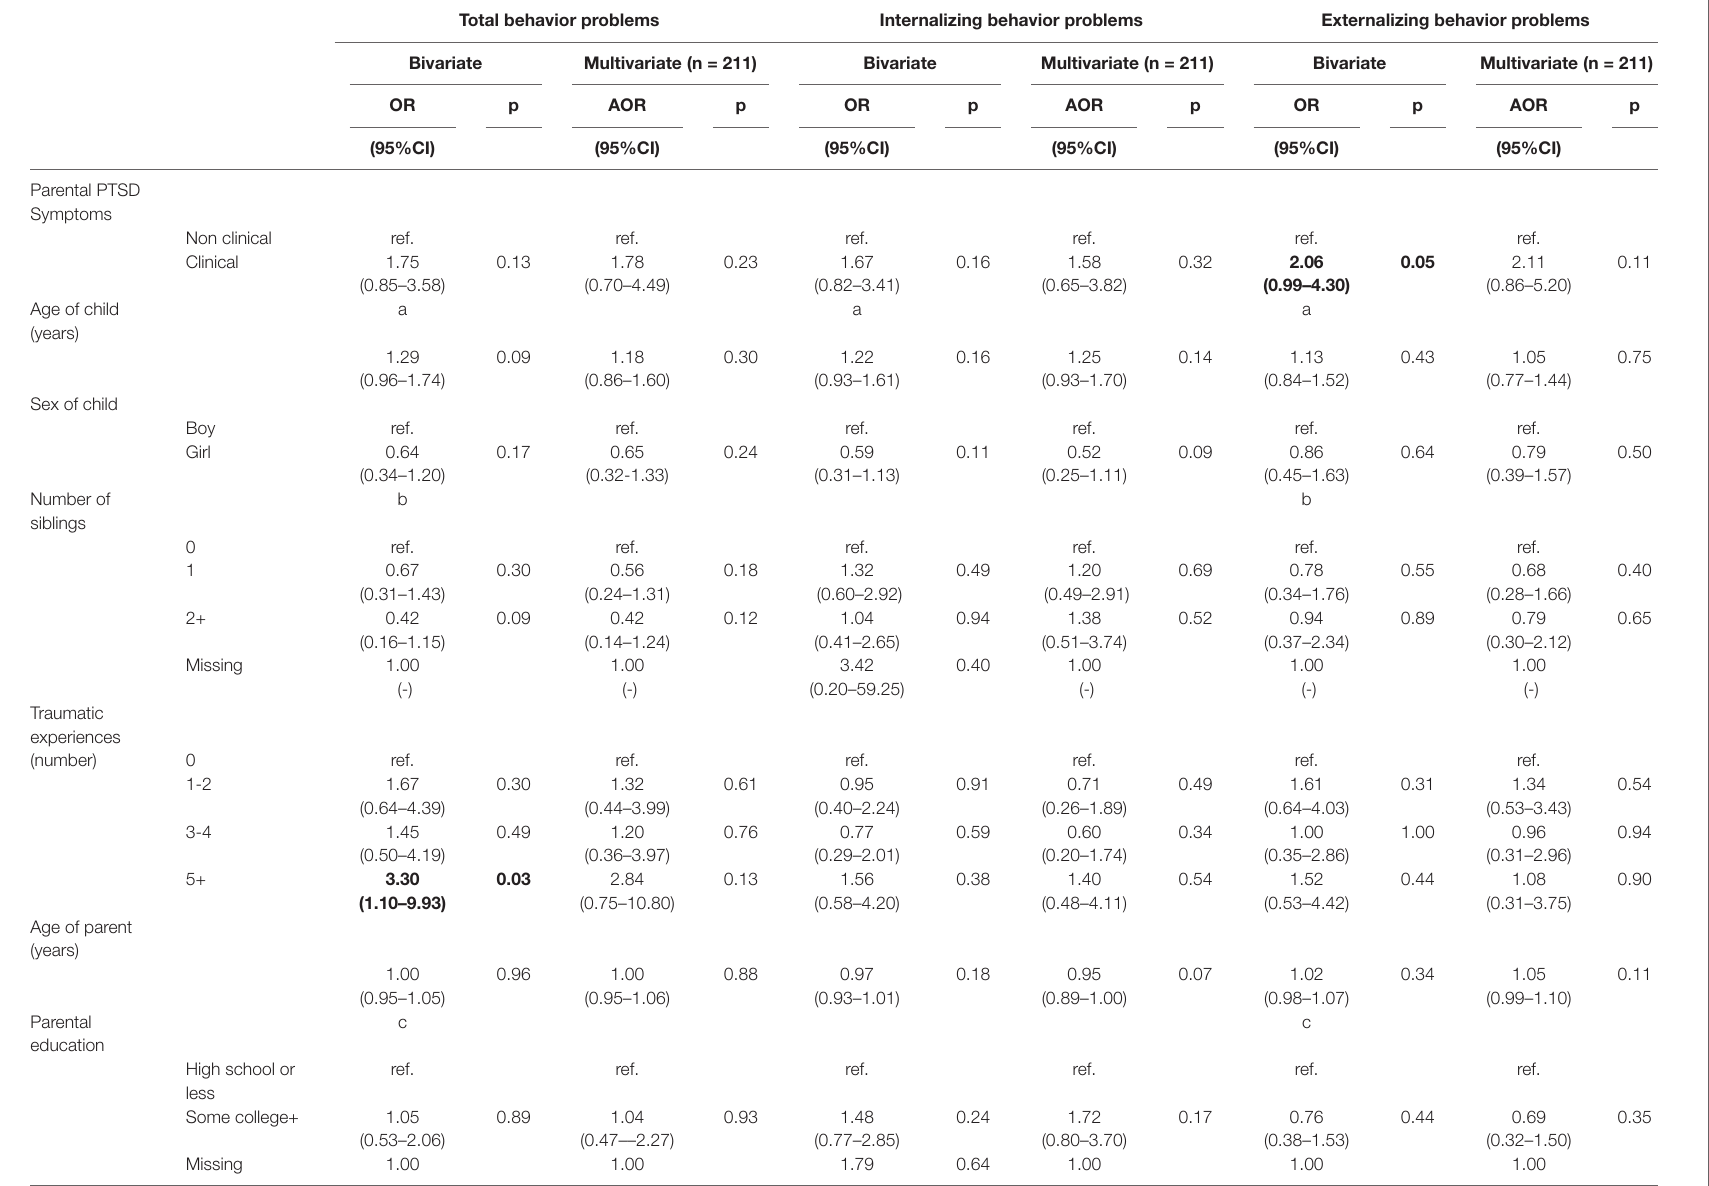
TABLE 3 | Association between parental PTSD symptoms and children’s behavioral problems in